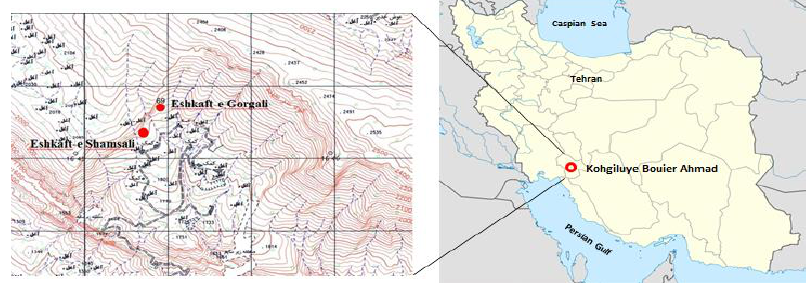
Figure 1. The location of rock shelters in Kohgiluye Bouier Ahmad